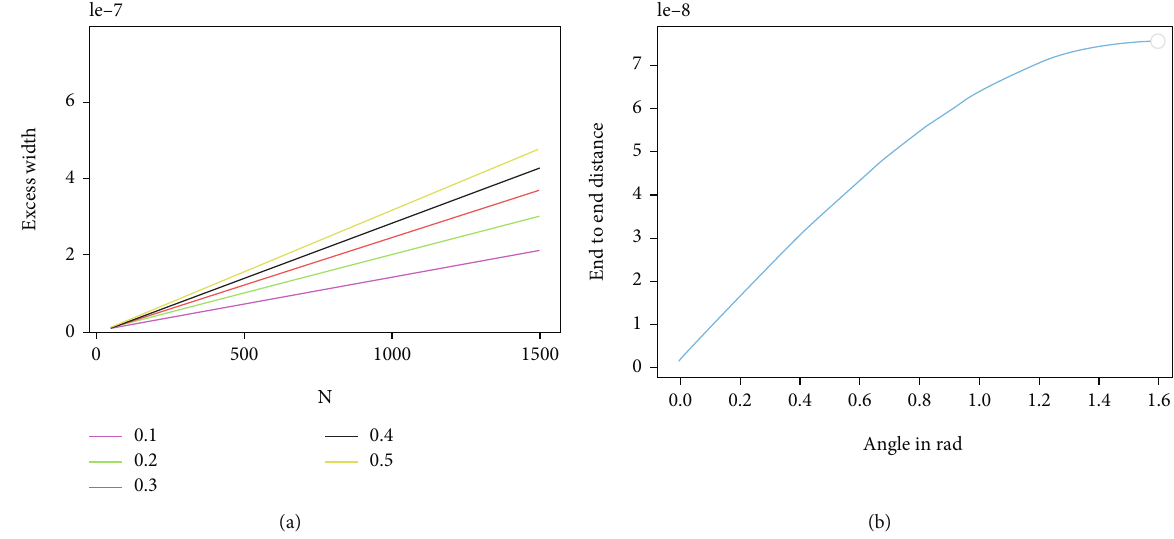
Figure 8: Plots of excess width of the polymer brush structure versus initiator structure size (primary data were taken from references [15, 16, 19, 21], and the plotted data (the excess width) was calculated using Equation (26).